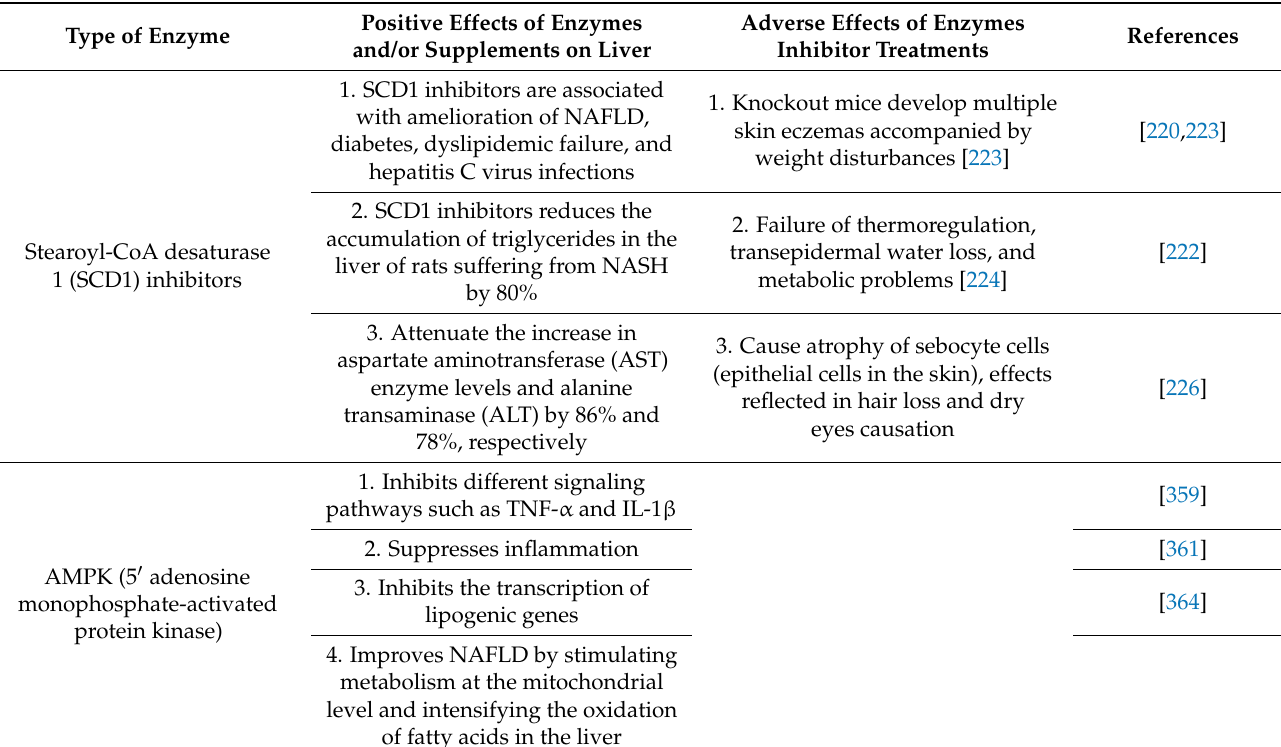
Table 4. The effects of different enzymes on